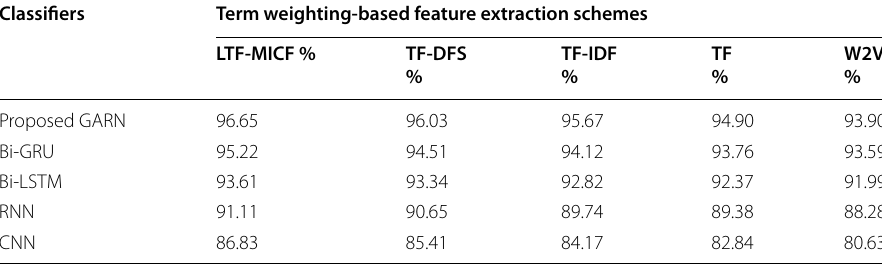
Table 5 indicates the precision performance analysis for existing and proposed classi- fiers with term weight schemes.